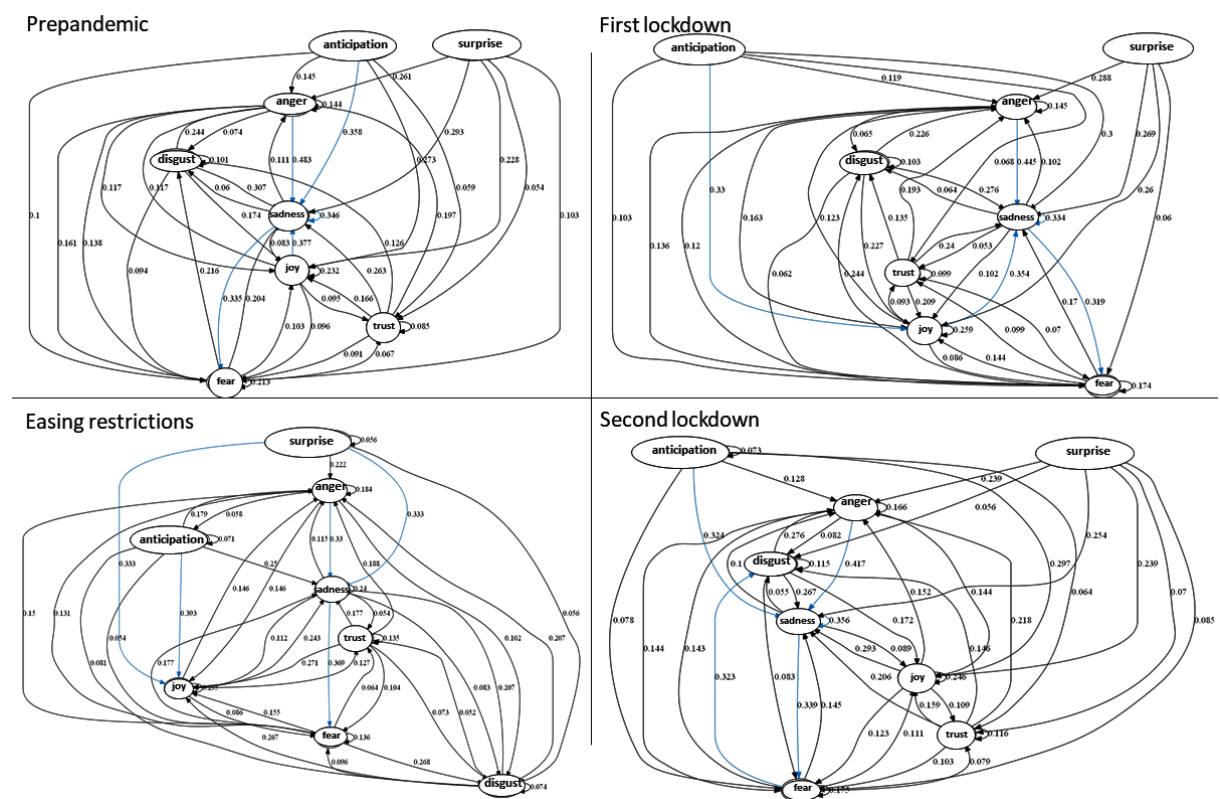
Figure 4. Emotion transitions of the four stages of the pandemic. Each arrow represents a transferring of one emotional state to another. The numbers on the arrows represent the likelihoods (ie, probabilities) of changed emotion